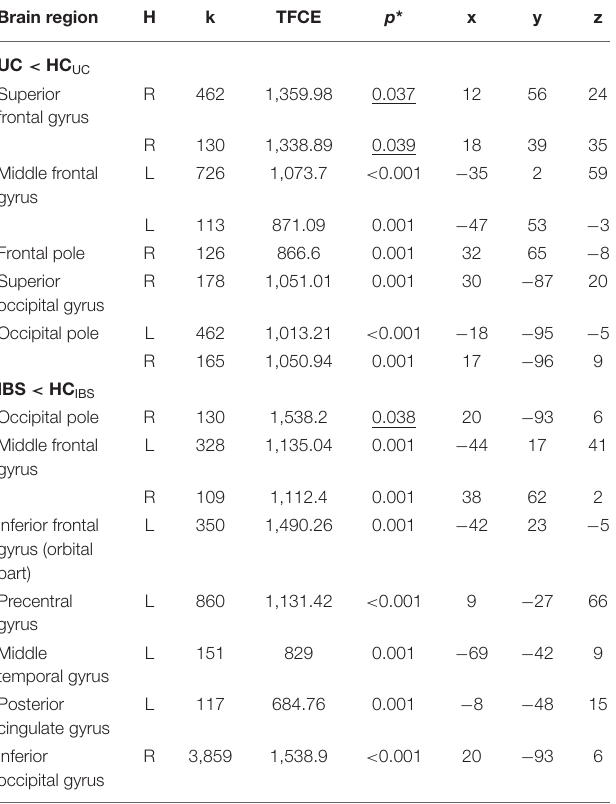
* P-values from FWE-corrected analyses are underlined; all other values indicate results from uncorrected analyses (interaction group × GI symptoms). H, hemisphere; L, left; R, right; k, cluster size; TFCE, threshold-free cluster enhancement; x, y, z, MNI coordinates; UC, ulcerative colitis; HC UC , matched healthy control group for UC group; IBS, irritable bowel syndrome; HC IBS , matched healthy control group for IBS group.